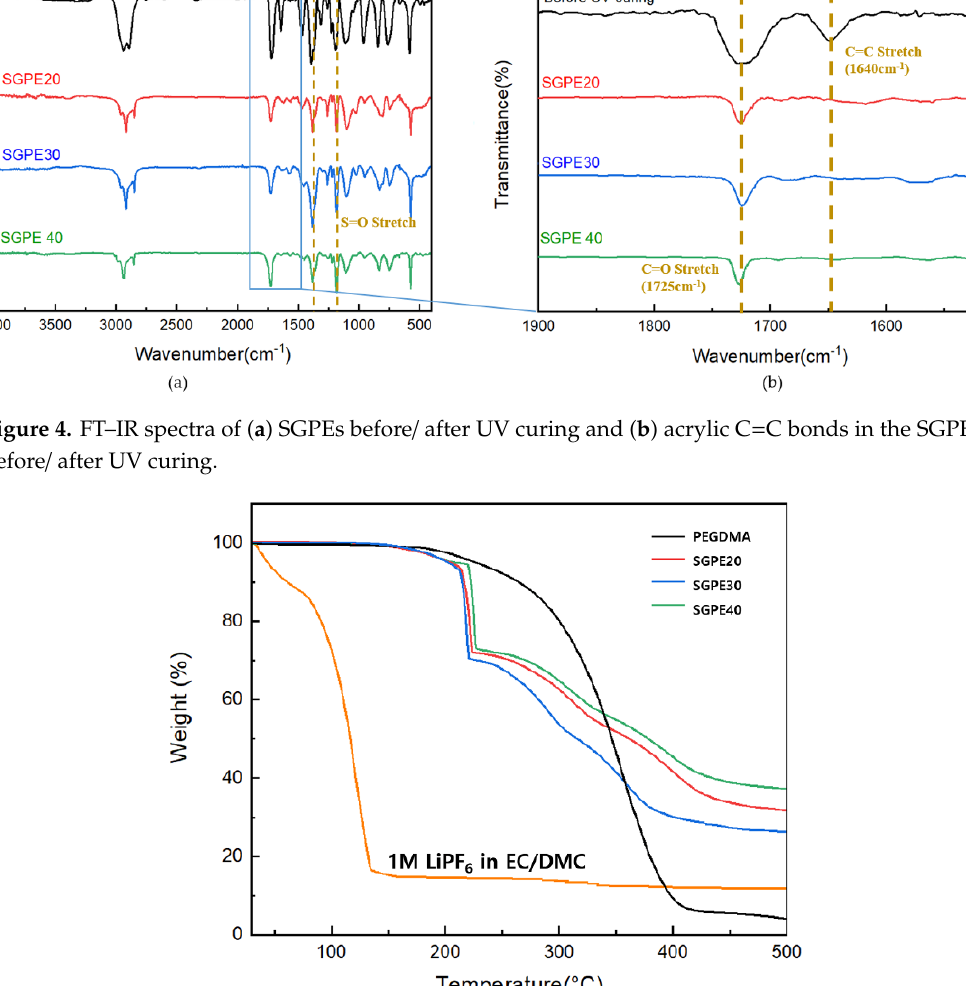
Figure 4. FT – IR spectra of ( a ) SGPEs before/ after UV curing and ( b ) acrylic C=C bonds in the SGPEs before/ after UV curing.